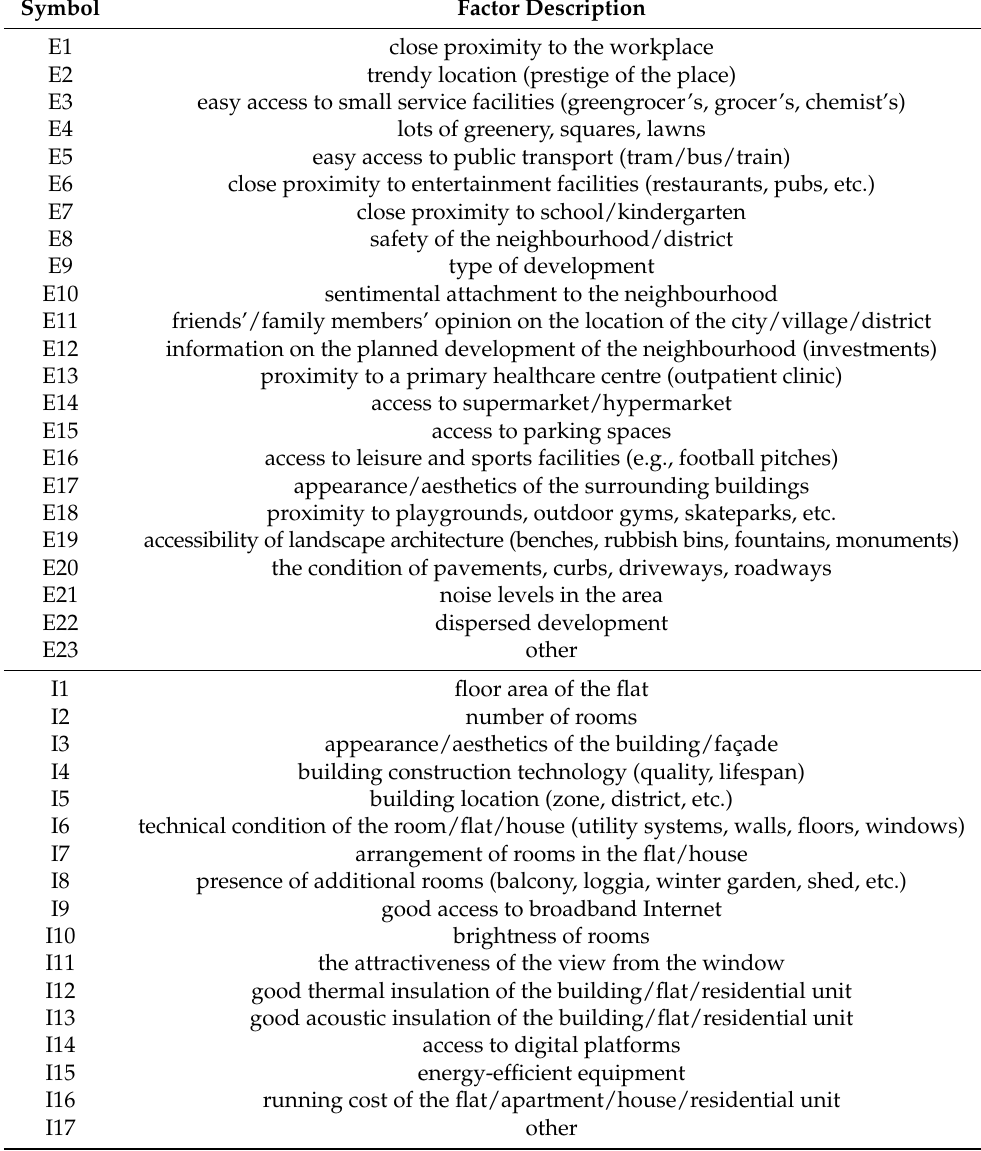
Table 2. External factors of location and internal factors of the